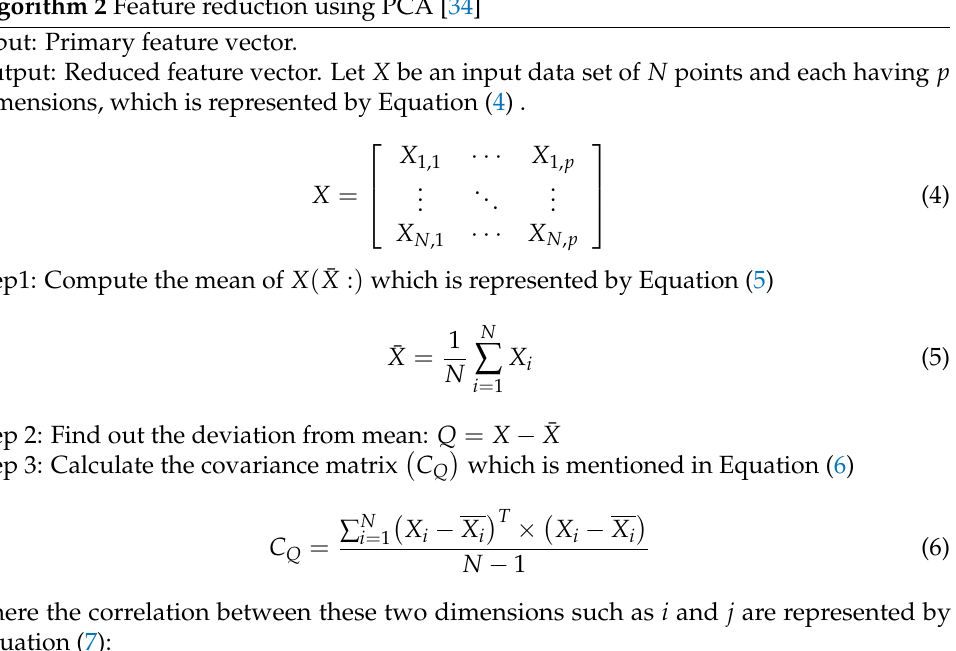
Algorithm 2 Feature reduction using PCA